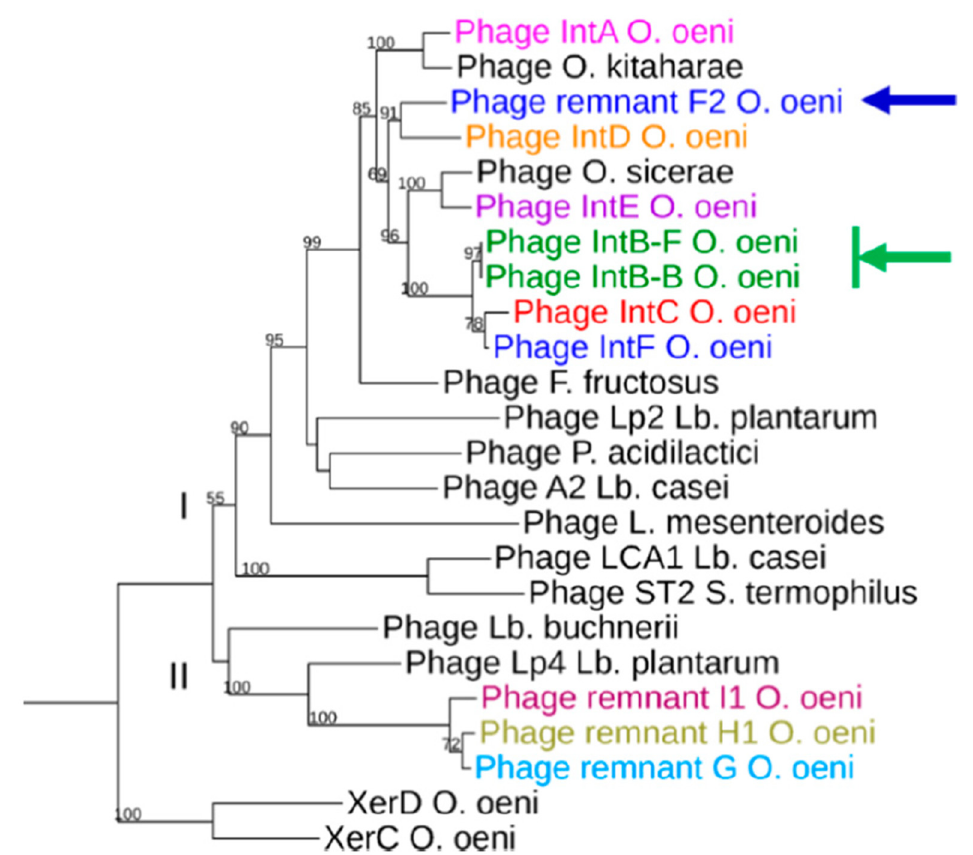
Figure 3. Phylogenetic tree of integrases found in O. oeni and other LAB. Sequences are distributed in clusters I and II. Their origin is as follows: Int A (IOEB0608); Int B Φ 10MC (AAD00268); Int